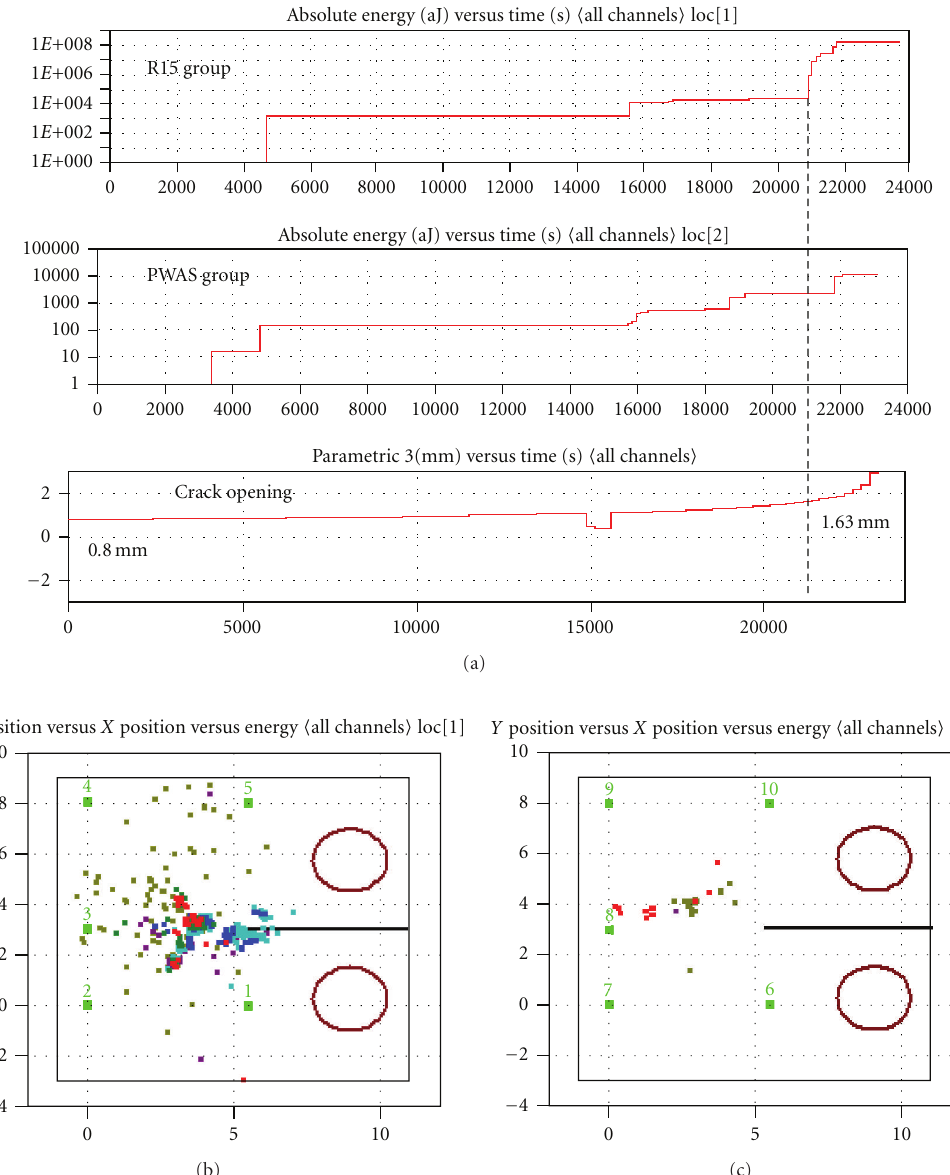
Figure 8: Comparison of crack localization in CT test on 1/2 (cid:4)(cid:4) steel specimen. (a) Cumulative acoustic energy by PWAS and R15I; (b) cracking detection and localization by R15I; (c) cracking detection and localization by PWAS.